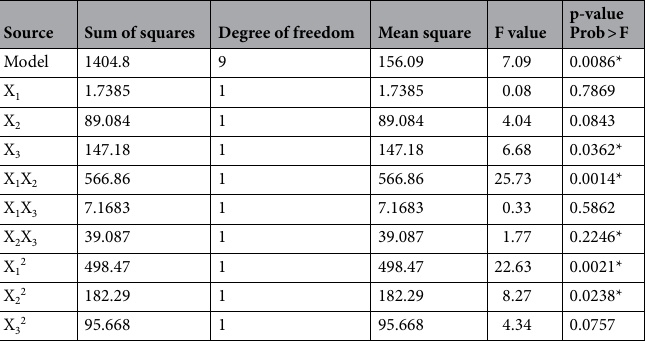
Table 2. Analysis of variance table. R 2 = 0.9011, Adj-R 2 = 0.7739. *Statistically significant at 95% probability